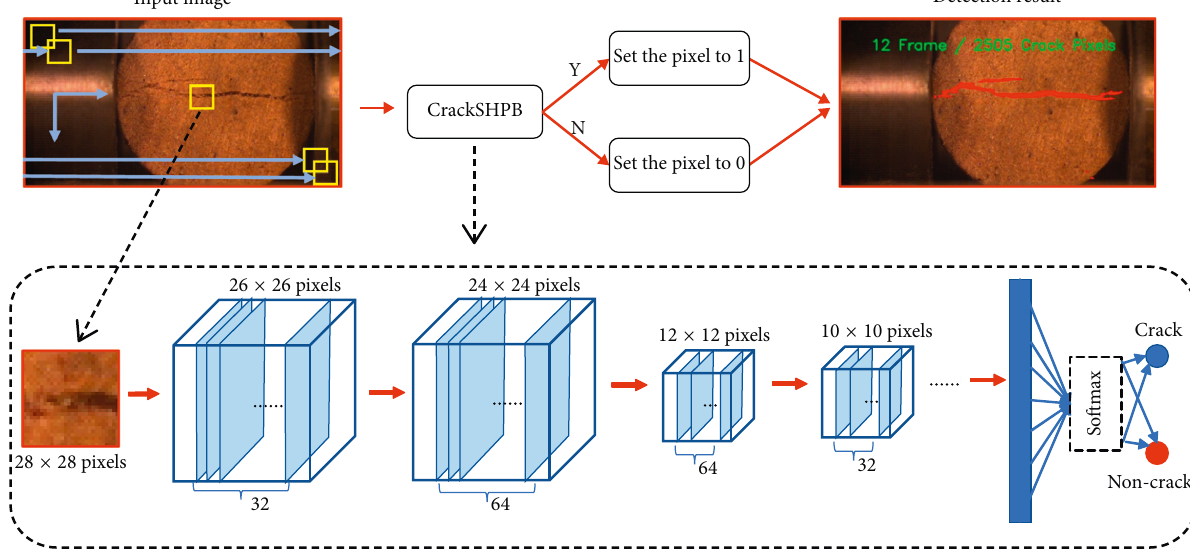
Figure 9: CrackSHPB model and crack identification flow